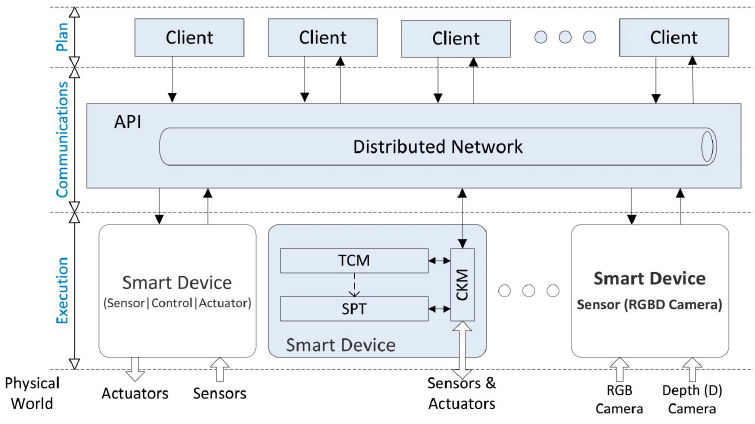
Figure 1. Topology of a distributed control system based on smart